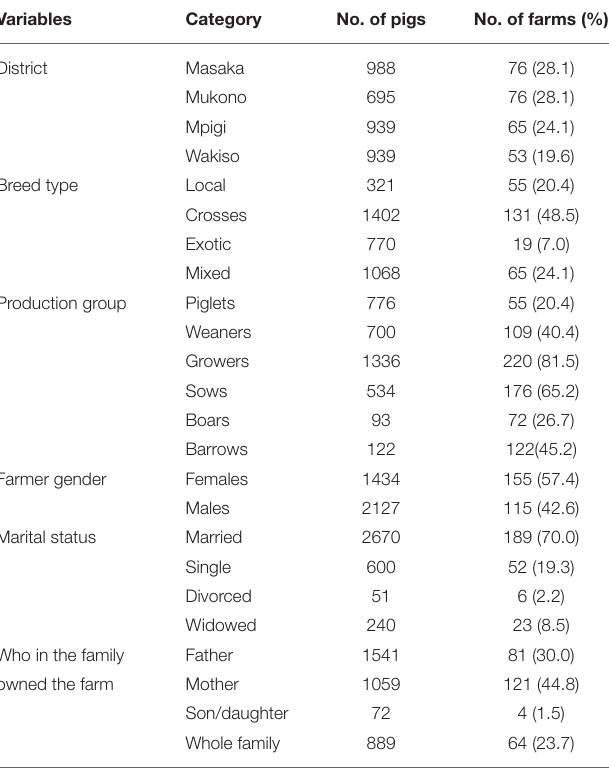
TABLE 2 | Pig farm owners’ demographic profile and number of pigs kept by district. Variables